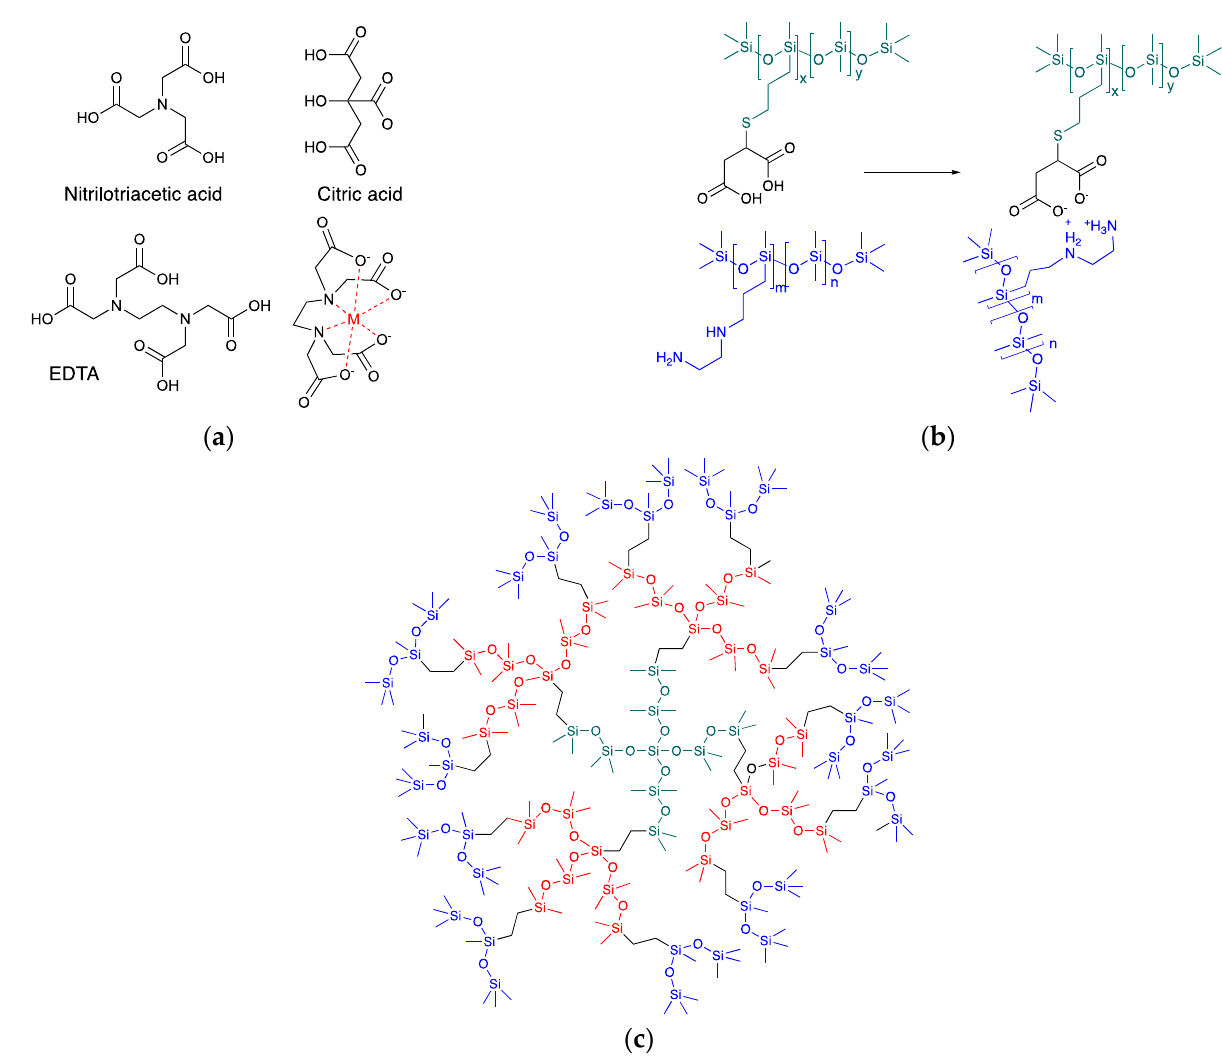
Figure 1. ( a ) Traditional chelating multidentate ligands. ( b ) Silicone elastomers crosslinked through ionic interactions [24,25]. ( c ) Example of a dendrimer prepared using the PR reaction [30,31] .